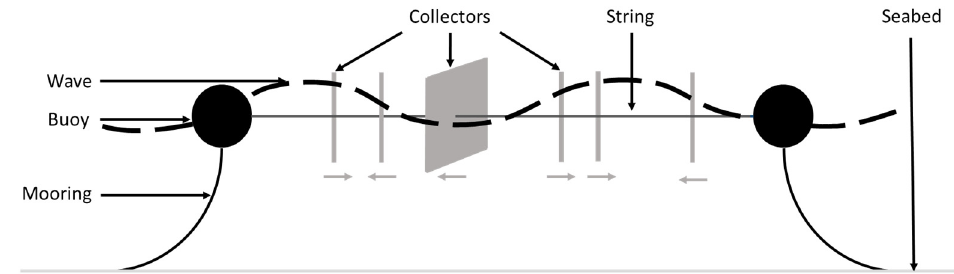
Figure 2. Wavepiston visual description.